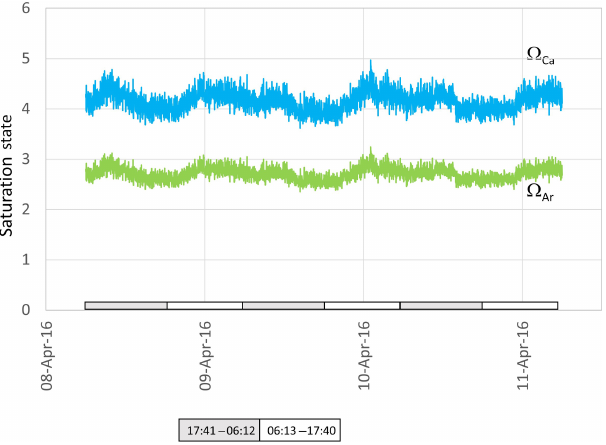
Figure 6. Aragonite (green) and calcite (blue) saturation values cal- culated from data presented in Fig. 4. Grey and white boxes indicate the time between sunset and sunrise.